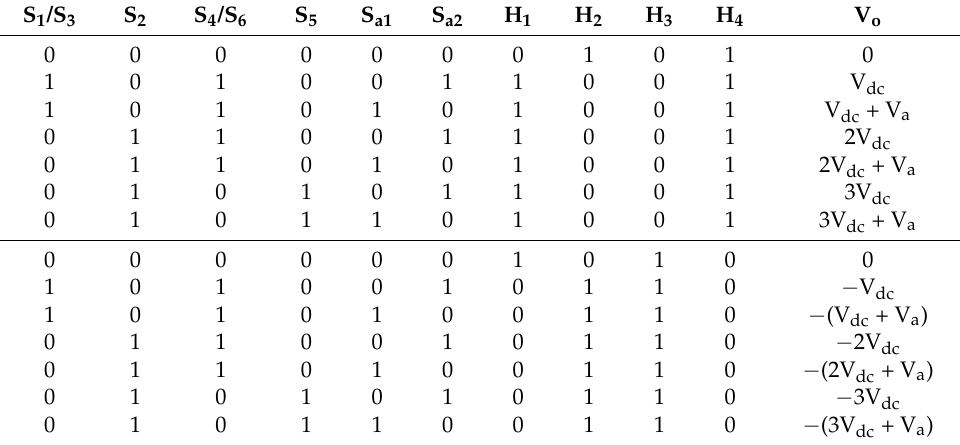
Table 1. Switching table with two